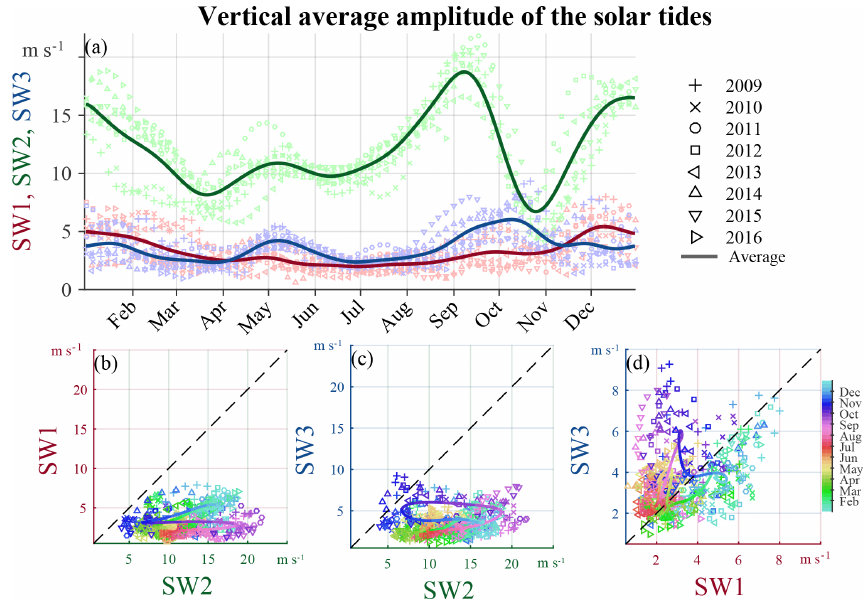
Figure 6. (a) Vertical average amplitudes of SW1, SW2, and SW3 scattered as a function of date. (b, c, d) Scatterplot between the vertical average amplitudes of SW2 vs. SW1, SW2 vs. SW3, and SW1 vs. SW3. In each panel, each point corresponds to a 5d interval in Fig. 3; and the solid colored line represents the multi-year